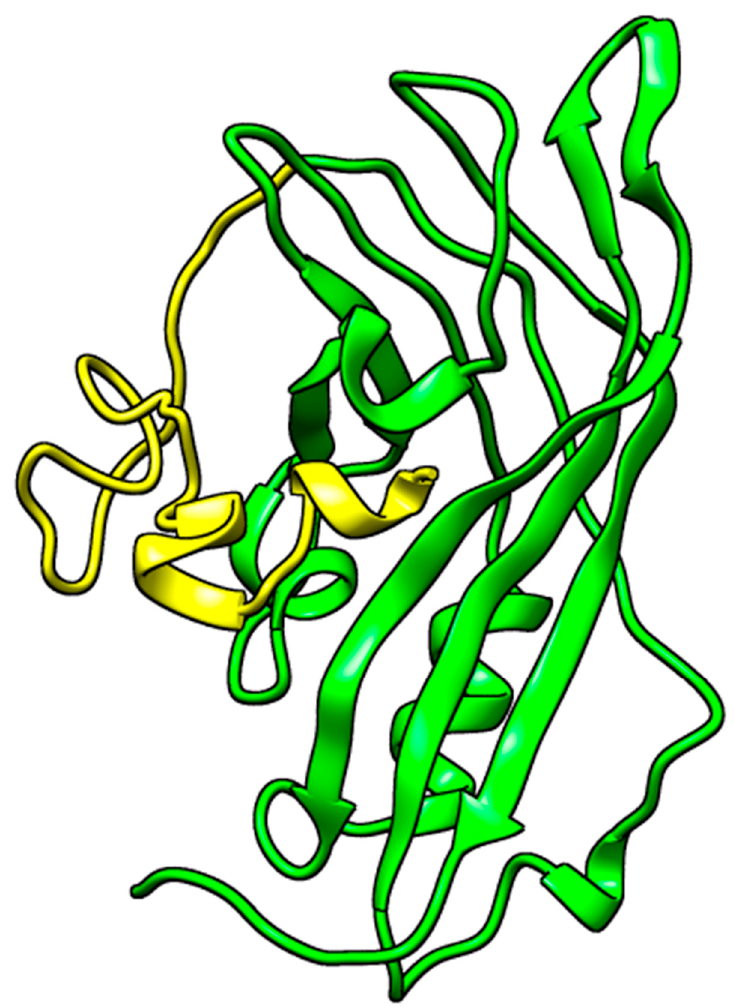
Figure 1. Structure of the selected VP40 NTD model generated via I-TASSER using 1ES6’s structure as template. Image was generated using UCSF Chimera version 1.16 [45]. Regions colored yellow represent missing residues that were remodeled.